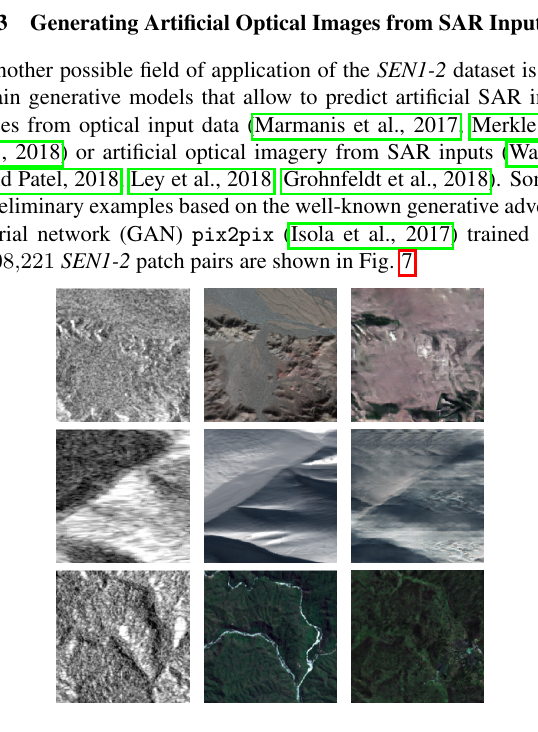
Figure 7. Some preliminary examples for the prediction of artificial optical images from SAR input data using the pix2pix GAN. In each row, from left to right: original Sentinel-1 SAR image patch, corresponding Sentinel-2 RGB image patch, artificial GAN-predicted optical image